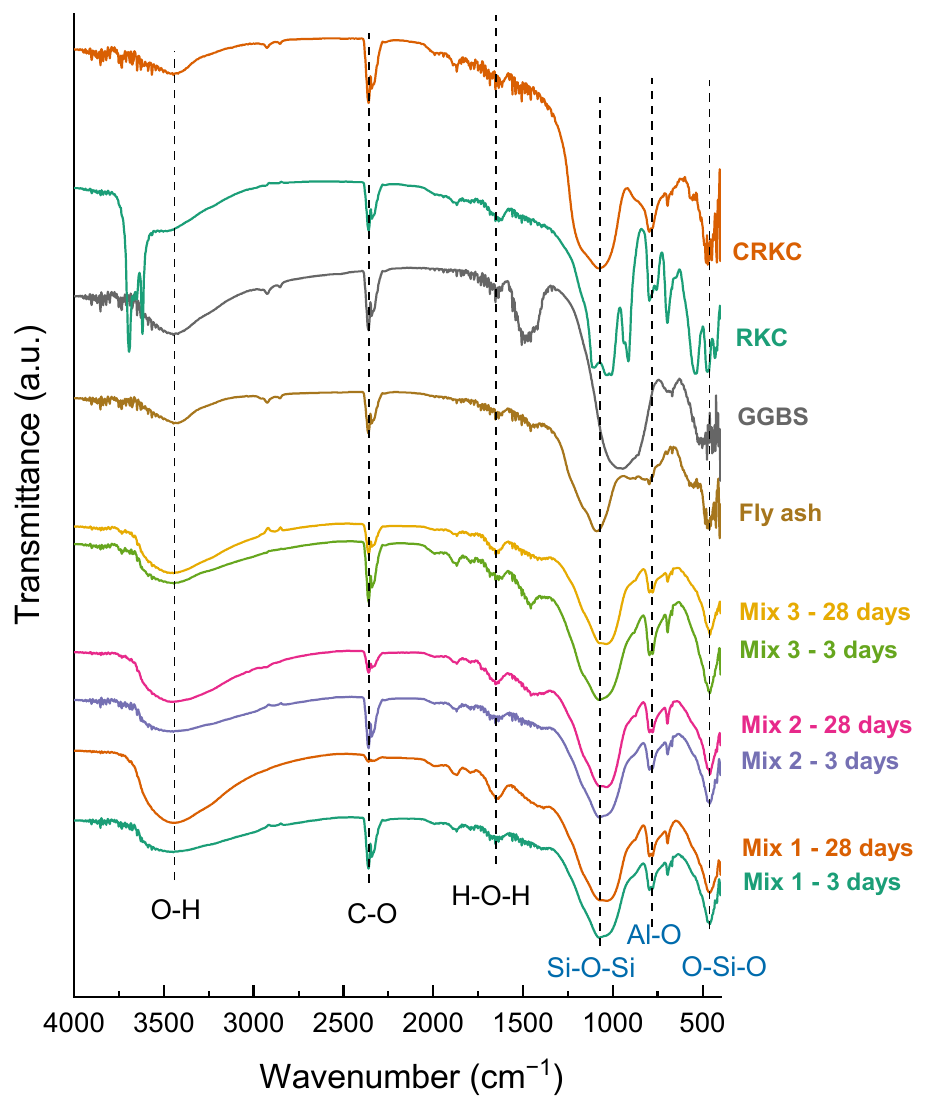
Figure 9. FTIR spectrums of developed geopolymer concrete samples.